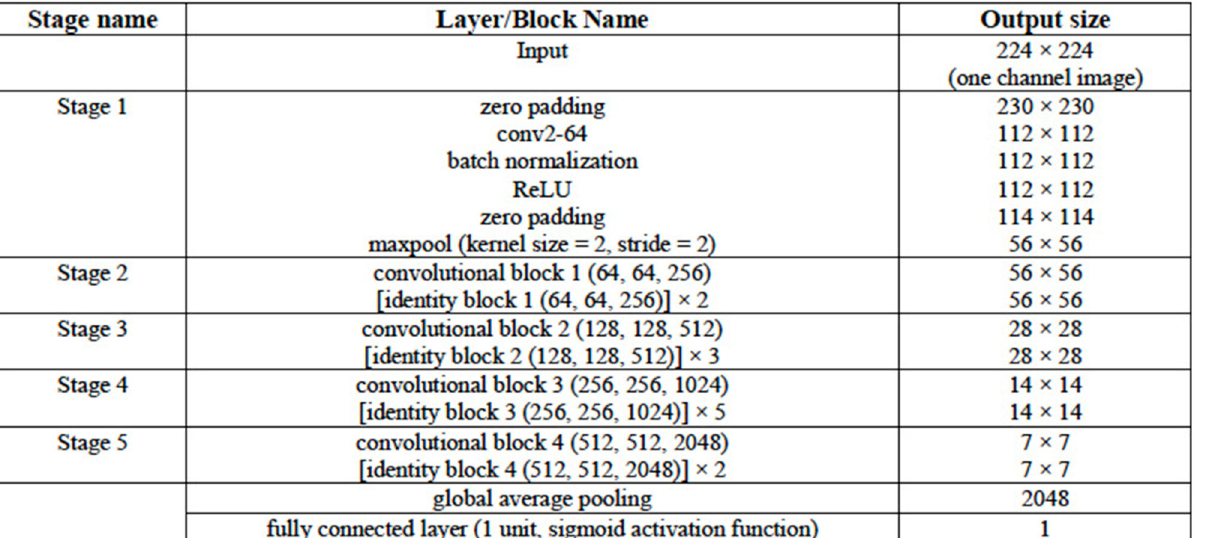
TABLE 3 | Configuration of the ResNet50 DL Architecture.